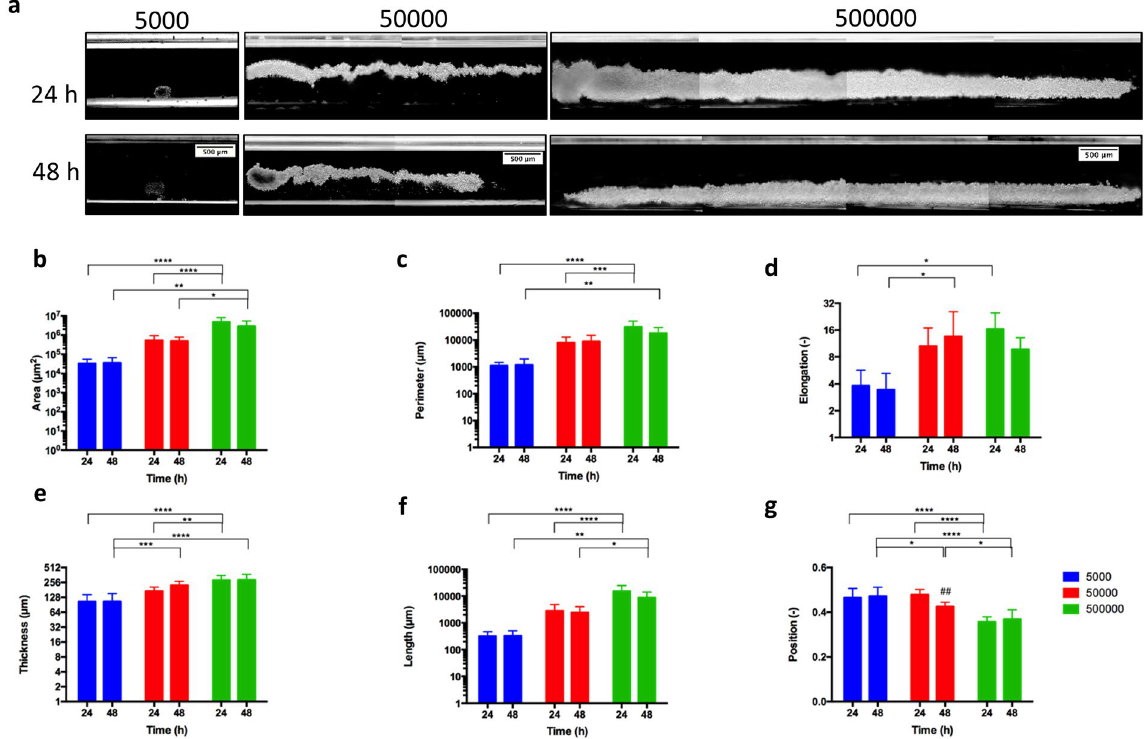
Figure 3. 3D cellular organization of D1 ORL UVA cells under microgravity. ( a ) Micrographs of cells levitated and assembled for 24 and 48 h (with 100 mM Gd-BT-DO3A) at different cell numbers (total 5000, 50000 and 500000 cells). Scale bars: 500 μ m. ( b – f ) Quantitative description of the cellular clusters formed for 24 or 48 h with magnetic levitation (100 mM Gd-BT-DO3A) at different cell numbers (total 5000, 50000 and 500000 cells); ( b ) area, ( c ) perimeter, ( d ) elongation, ( e ) thickness and ( f ) length, and ( g ) position of the clusters between magnets (the top point of the bottom magnet:0, the bottom point of the top magnet: 1). Data are plotted as mean of replicates with error bars ( ± SD) and statistically analyzed using a two-way ANOVA and Sidak posthoc test. Statistical significance was defined as P <